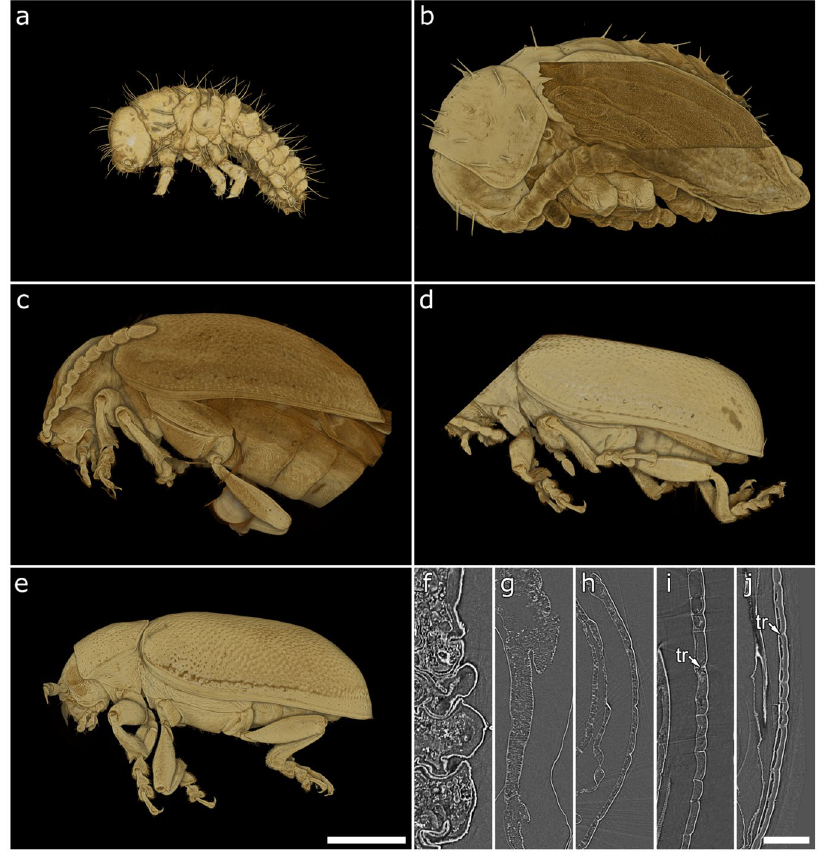
Figure 2. Results from SR- μ CT scans showing volume renderings ( a – e ) and cross-sections ( f – j ) of the respective dataset. 3rd instar larva, which exhibits a soft cuticle ( a , f ); young pupa ( b , g ), pupal skin partly digitally removed to reveal the developing elytron; imago immediately after ecdysis ( c , h ) the young imago ( d , i ), which shows a fully-formed yet rucked up cuticle and the formation of trabeculae (“tr” in the figure); old imago ( e , j ) with a fully developed cuticle. Scale bars: 1